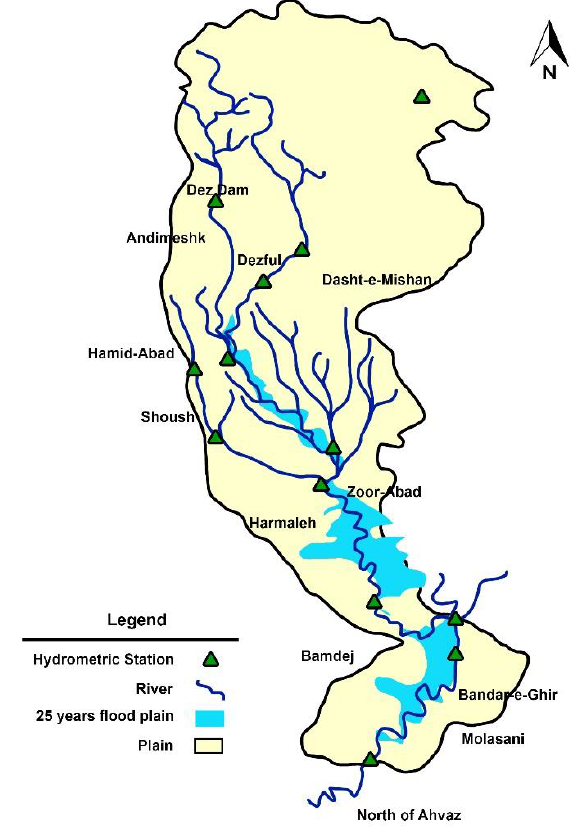
Figure 2. The catchment area of the Dez and Karoon rivers.